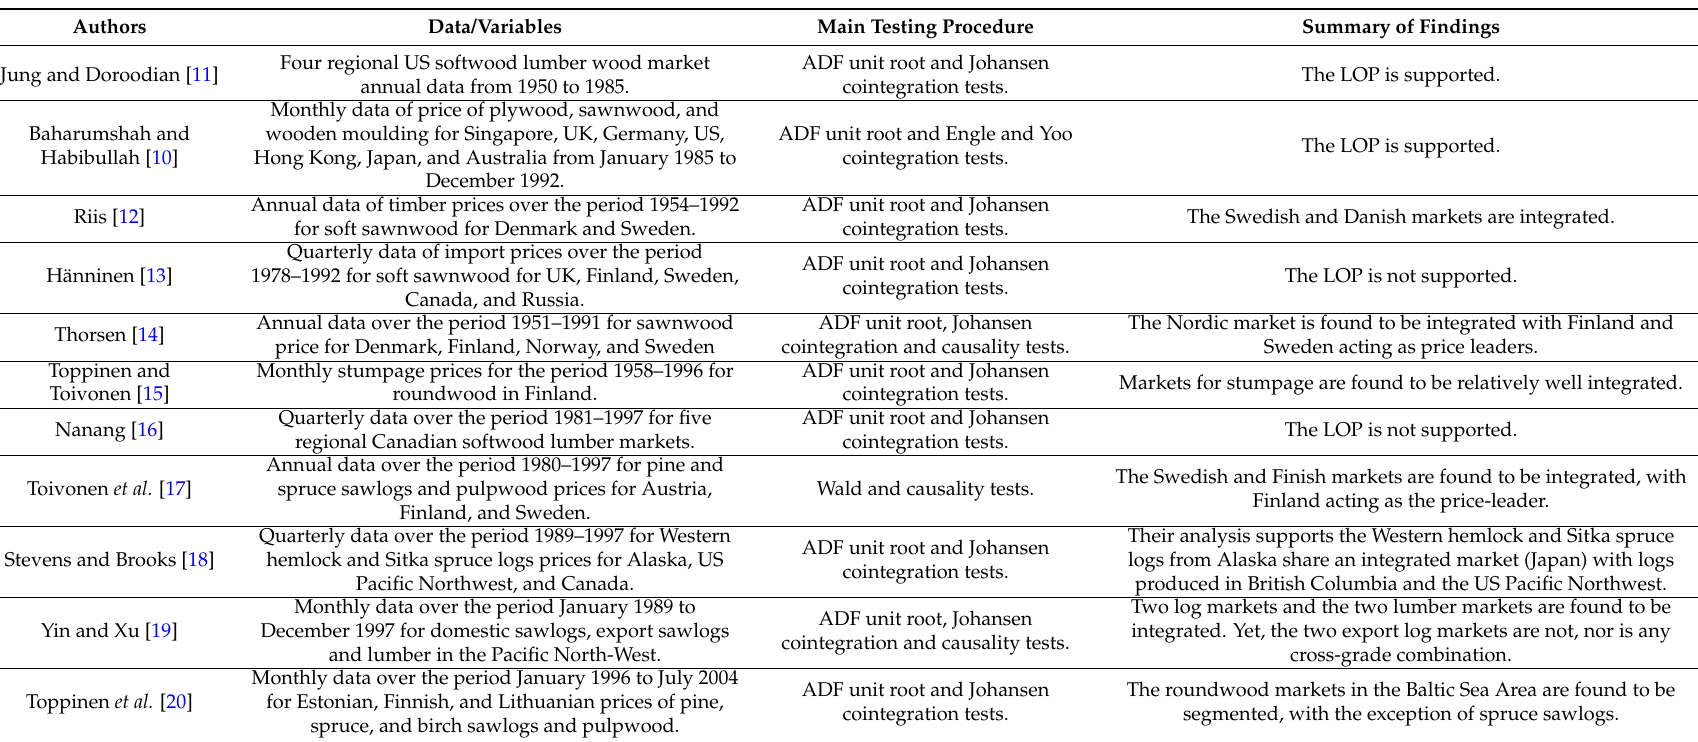
Table 1. Summary of